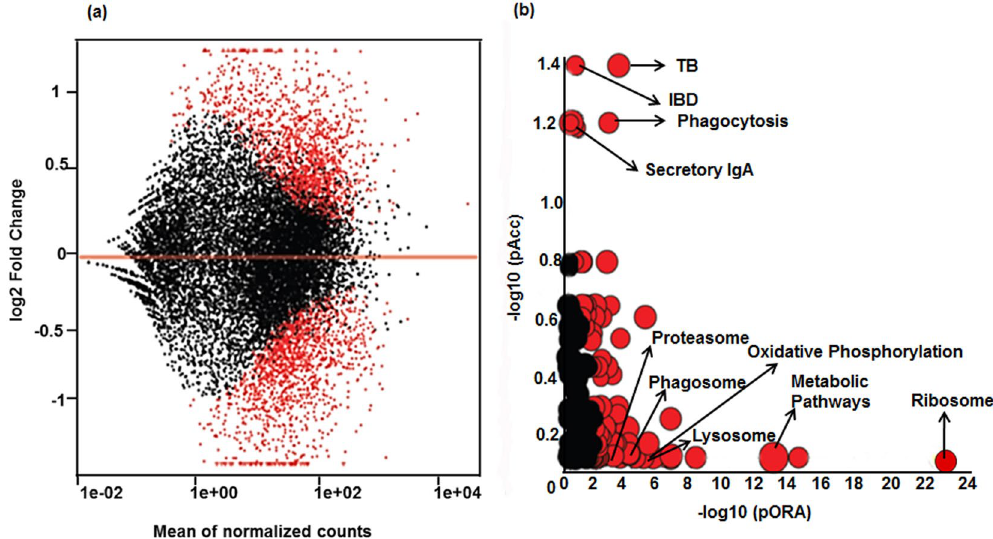
Figure 1. Differential gene expression and pathways between control and sarcoidosis monocytes. ( a ) Scatter plot of the entire gene expression data (healthy versus sarcoidosis monocytes) analyzed by DEseq2 analysis tool, where the log 2 -fold change ( > 0.5) of each gene is plotted against the total number of counts recorded for that gene. DE genes (FDR < 5%) are highlighted in red. ( b ) Significant pathways modulated in sarcoidosis monocytes as compared to healthy controls. Pathway analysis was done on the DE genes (log 2 -fold change > 0.6 and FDR < 5%) using iPathwayGuide analysis tool that uses two types of evidence: the over-representation on the horizontal axis (pORA) and the perturbation on the vertical axis (pAcc). Significant pathways (FDR < 5%) are shown in red, whereas non-significant are in black. The size of the circle is proportional to the number of genes in that